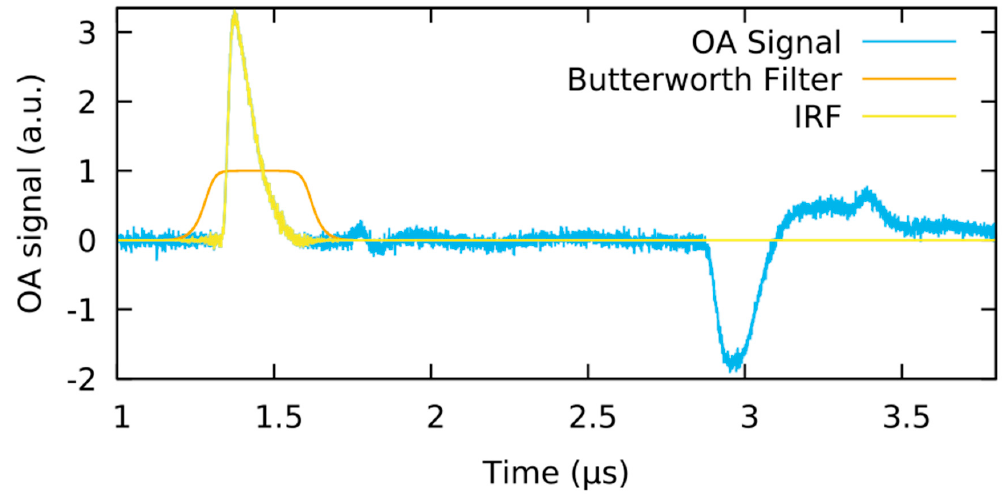
Figure 5. The optoacoustics (OA) signal of black plastic (blue) shows unwanted reflections. Butterworth filter as used on OA signal (orange). Resulting instrument response functions (IRF), only featuring the delta peak response (yellow).